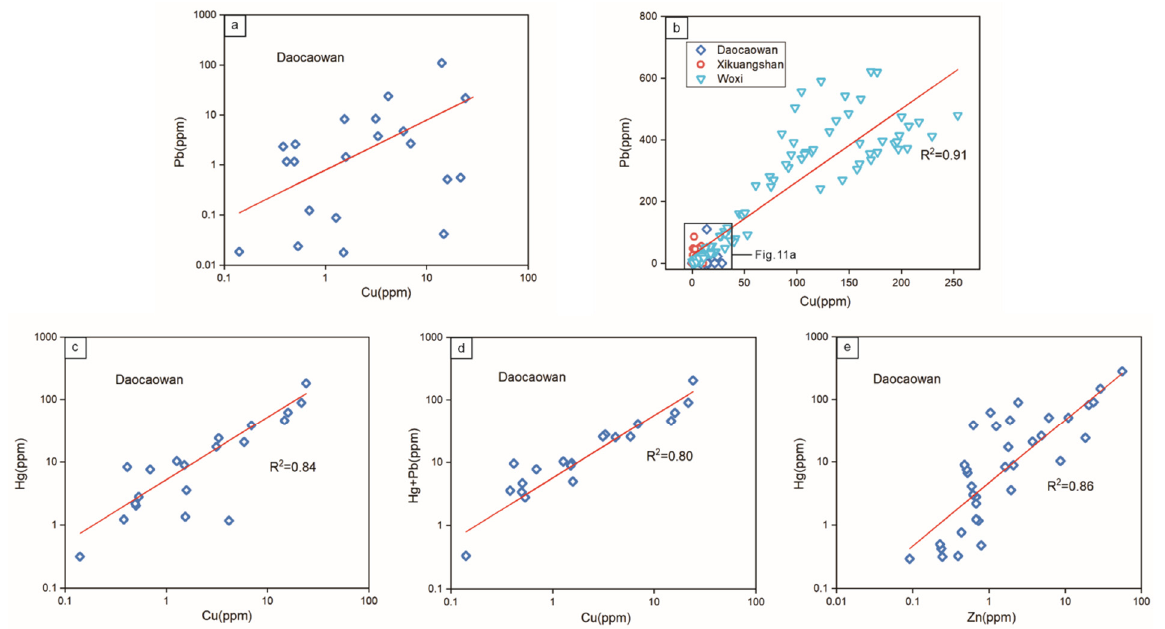
Figure 11. Correlation plots of ( a , b ) Cu vs. Pb, ( c ) Cu vs. Hg, ( d ) Cu vs. Hg + Pb, and ( e ) Zn vs. Hg in stibnite determined by LA-ICP-MS. The stibnite data of Xikuangshan and Woxi from [9].